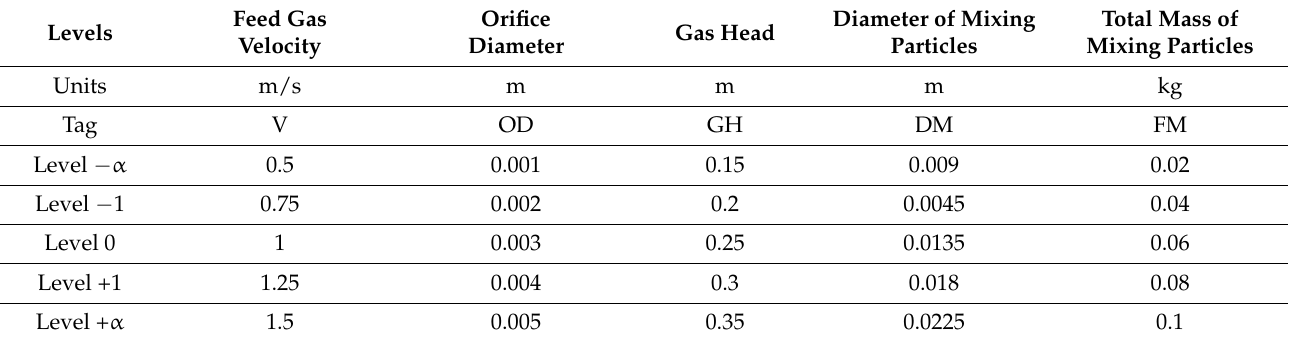
Table 2. Levels of independent parameters of CCD